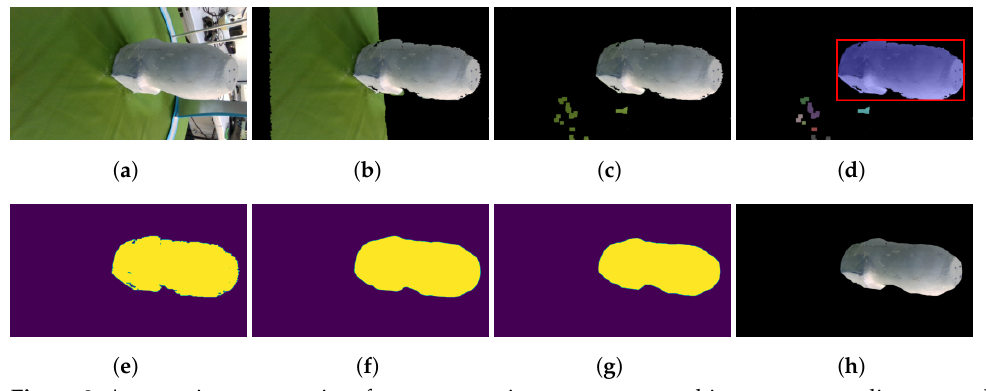
Figure 9. Automatic segmentation, feature extraction, contour smoothing, contour outlier removal, and masking process via the algorithms for one camera image. This shows the automatic segmentation from start to finish. ( a ) Original. ( b ) No background. ( c ) Color removal. ( d ) Region box. ( e ) Binary image. ( f ) Median. ( g ) Erosion. ( h )